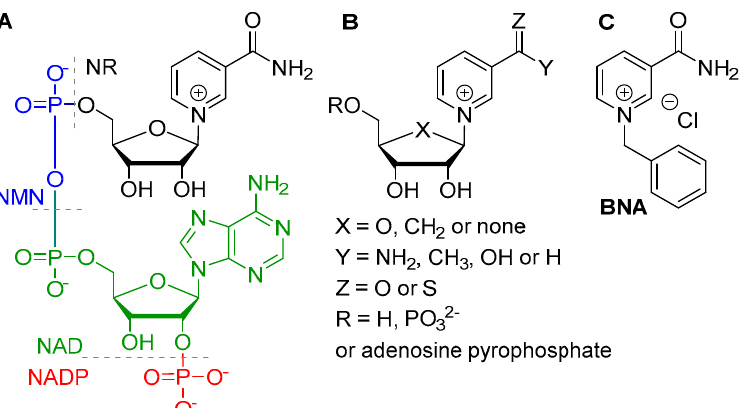
Figure 1. ( A ) Schematic representation of the natural NAD(P); ( B ) Naturally-based analogues; ( C ) synthetic analogue.